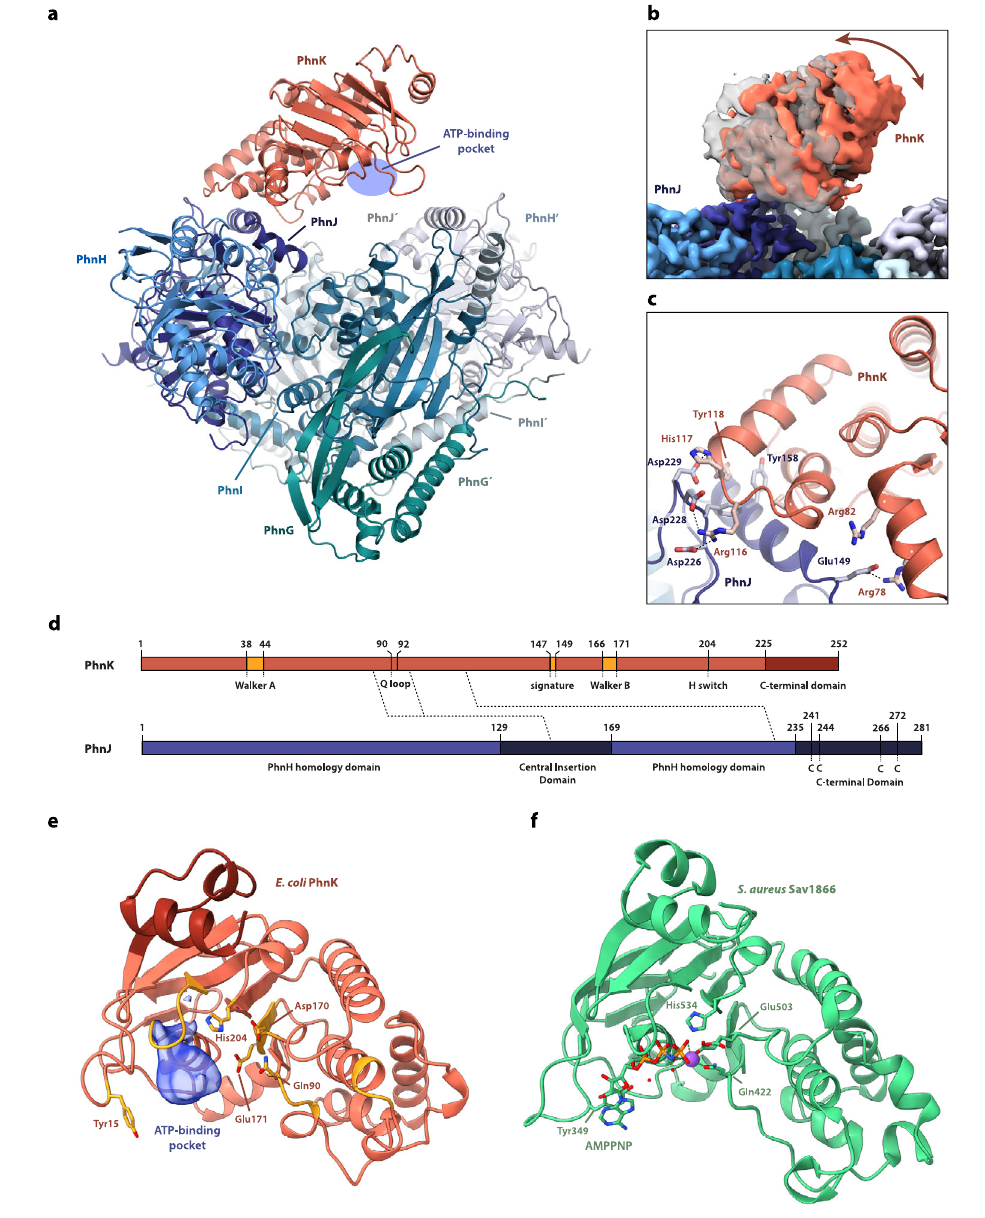
Fig. 1 | The C-P lyase core complex can bind a single, fl exible PhnK subunit. a Overview of the structure of the C – P lyase core complex (PhnGHIJ, blue/green) bound to a single subunit of PhnK (red) with the names of individual subunits indicated. The ATP-binding pocket of PhnK is shown with a blue ellipse. b Surface representationoftheEMdensityshowingtheextentofthetiltingmotionobserved inPhnK.Thetwoextremestatesareshowningreyandred,respectively. c Close-up of the interaction between PhnK (red) and the PhnJ central insertion domain (CID, blue) with relevant residues shown as labelled sticks and interactions with dashed lines. d Overview of the domain structure of PhnK (top, red) and PhnJ (bottom, blue)withresiduenumbersindicated.ForPhnK,thelocationofthecoreABCmotifs (WalkerAandB,Qloop,signaturemotif,andHswitch)areindicatedinorangeand the C-terminal domain in dark red. For PhnJ, the features that distinguish the